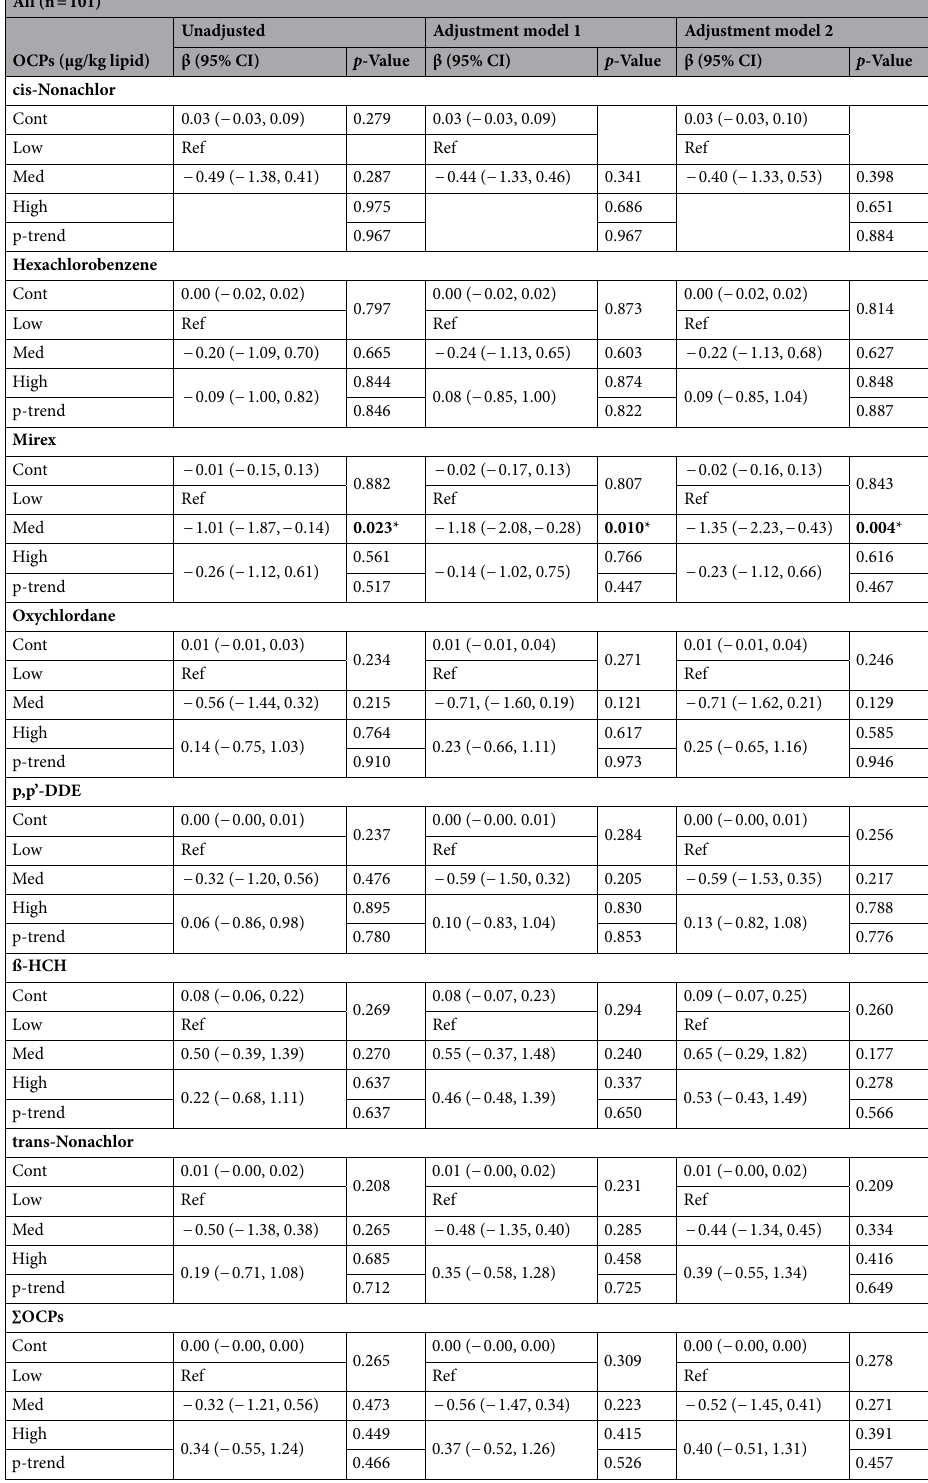
Table 5. Linear regression analysis of the associations between prenatal OCP exposure and continuous hyperactivity score: Greenlandic children 3–5 years of age born 2014–2016, the ACCEPT birth cohort. n Number of participants in parameter, β Linear regression coefficient in score points, CI confidence interval, Bold text and *= Significant ( p ≤ 0.050), Bold text and ** = Borderline significant ( p ≤ 0.100), Adjustment model 1: Maternal plasma cotinine, maternal educational level, maternal age at delivery, Adjustment model 2: Adjustment model 1 + breast-feeding duration, Med = Medium, Cont. = Continuous, OCPs organochlorine